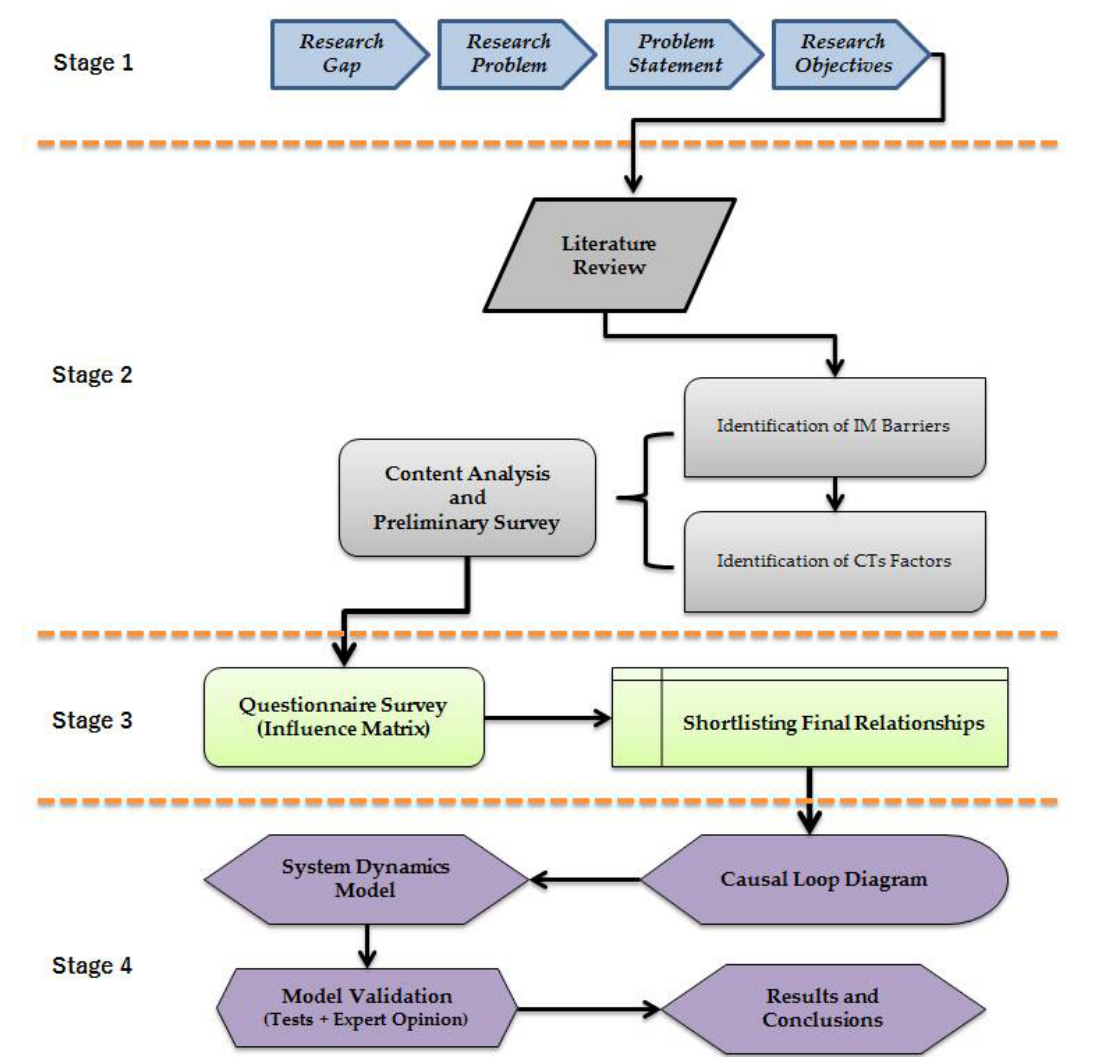
Figure 1. Schematic representation of research methodology.